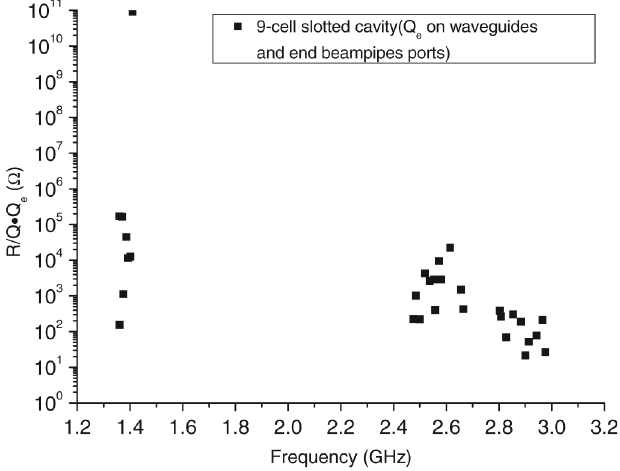
FIG. 14. Monopole modes of the nine-cell slotted cavity.